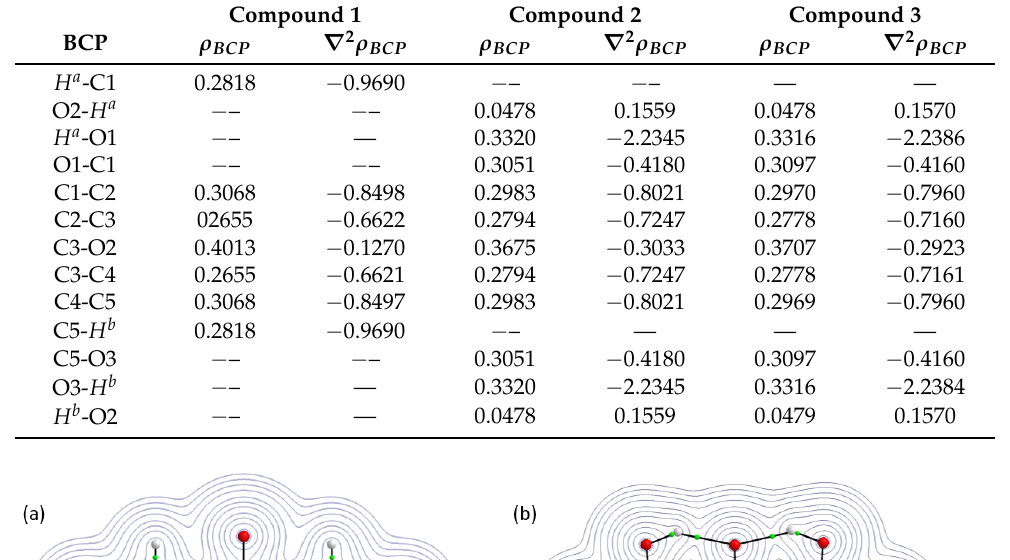
Table 2. Bond Critical Points (BCPs) obtained for the selected geometric parameters of compounds 1 , 2 and 3 in vacuo at B3LYP/6-311+G(d) level of theory. Electron density ρ BCP is given in e · a − 3 units, and its Laplacian ∇ 2 ρ BCP in e · a − 5